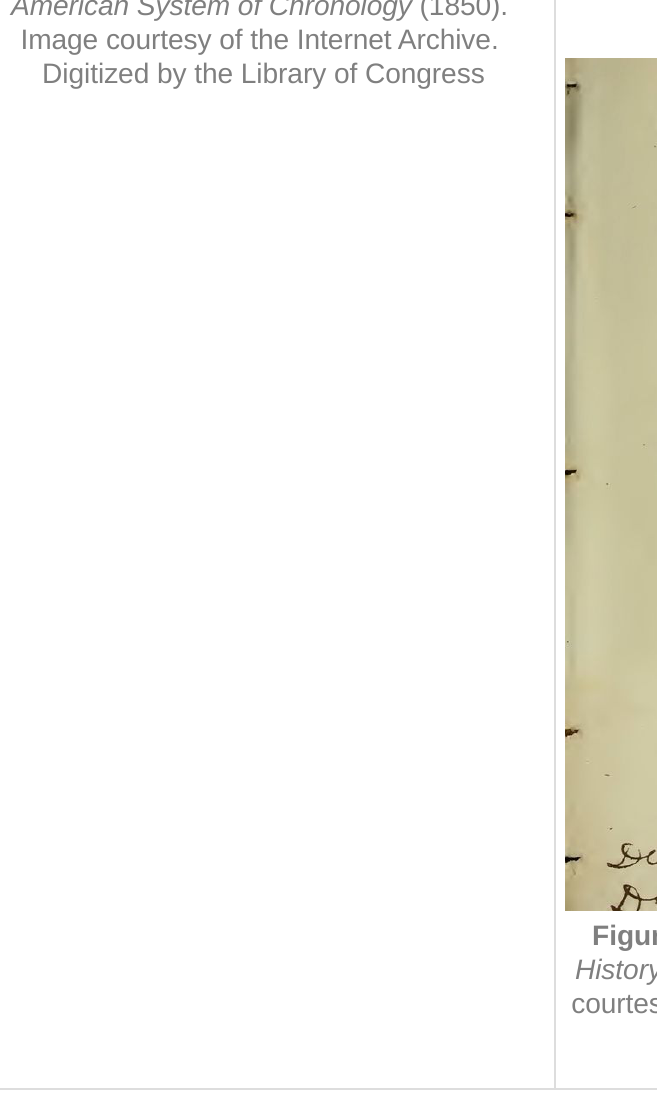
Figure 5. The title page of The Polish- American System of Chronology (1850). Image courtesy of the Internet Archive.